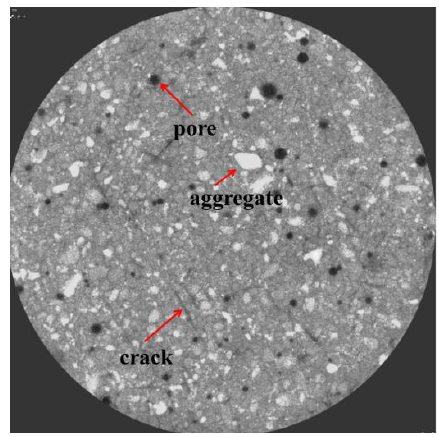
Figure 3. The horizontal slice.